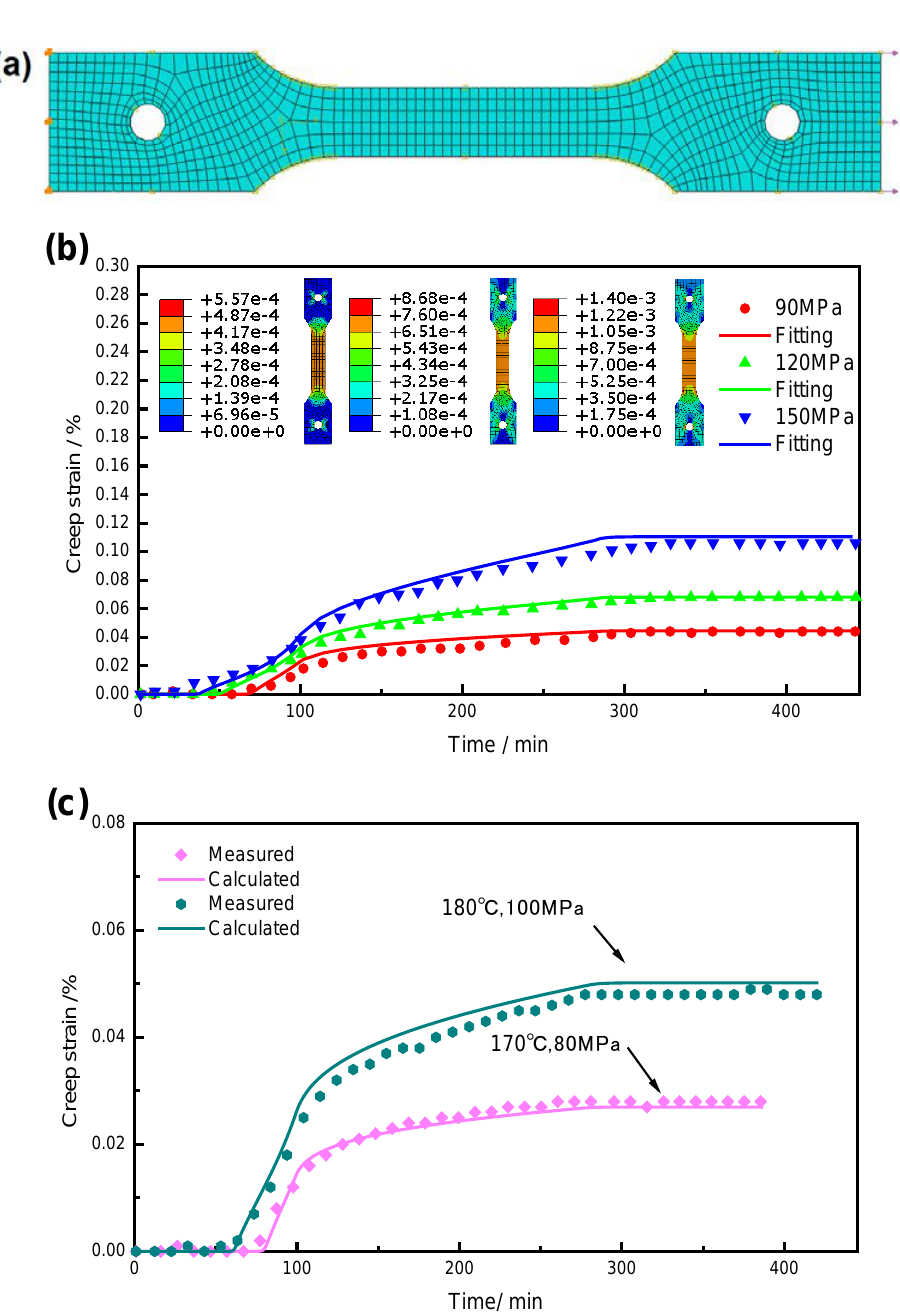
Figure 13. Comparisons between experimental and calculated results of creep tests: ( a ) FE mesh used in the present work; ( b ) fitting creep strain; ( c ) calculated creep strain.